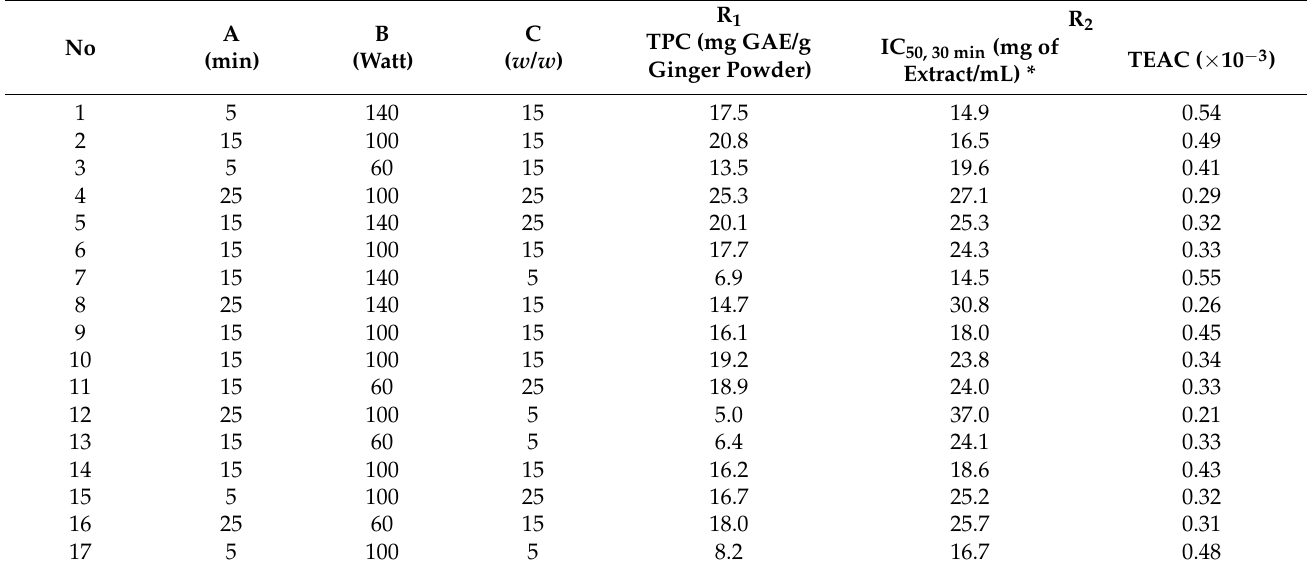
Table 3. Measured responses of TPC (R 1 ) and DPPH radical scavenging ability (R 2 ). A: extraction time (min); B: ultrasound power (Watt); C: NaDES-to-ginger ratio ( w/w